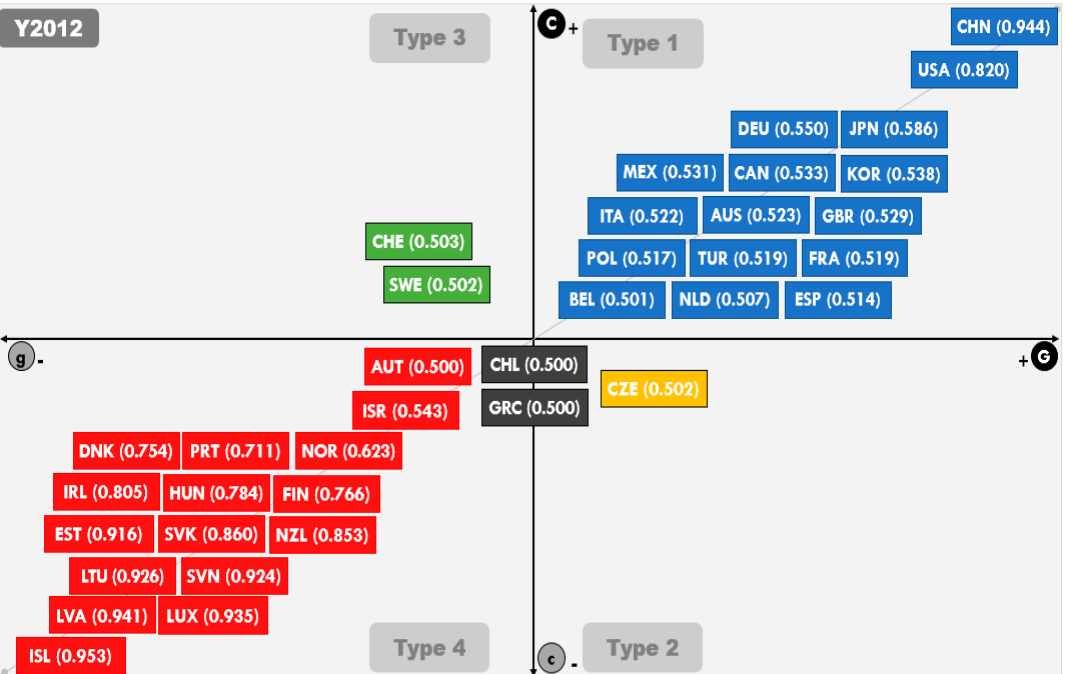
Figure 3. The Location of Link Types of the 37 Case Countries in 2012.